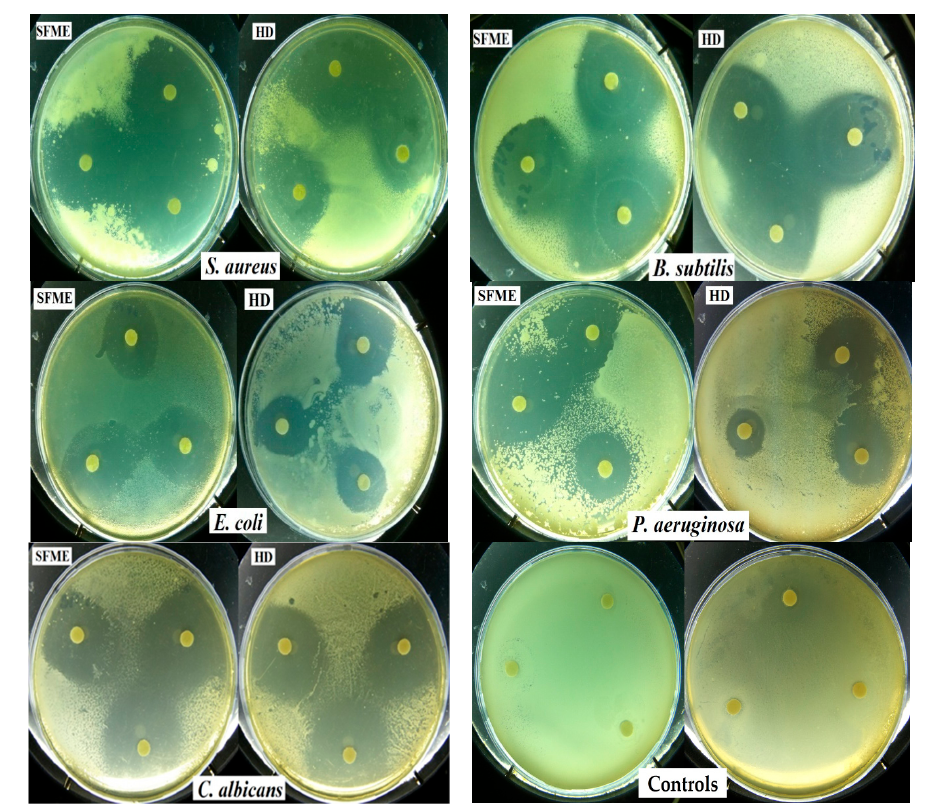
Figure 5. Photograph showing inhibition zones of the microbial growth of all tested microorganisms and control.